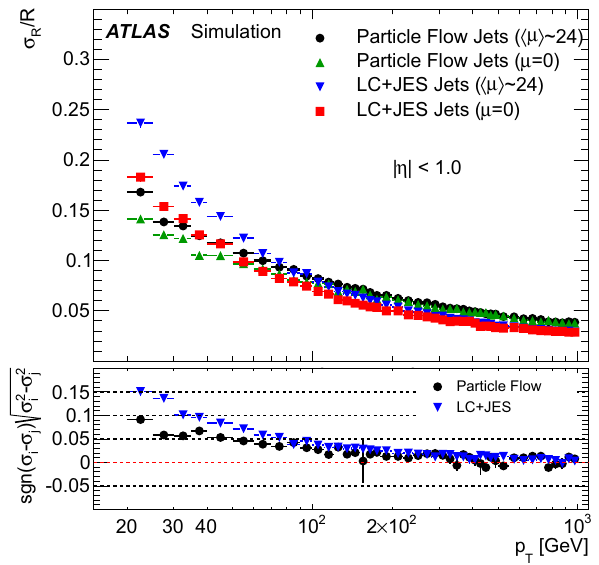
Fig. 33 The resolutions of calorimeter and particle flow jets deter- mined as a function of p T in MC dijet simulation, compared with no pile-up and conditions similar to those in the 2012 data. The quadratic difference in the resolution with and without pile-up is shown in the lower panel for LC + JES ( blue ) and particle flow ( black ) jets. The data are taken from dijet samples, with and without pileup, with < 500GeV and the statistical uncertainties on the number 20 < p lead T of MC simulated events are